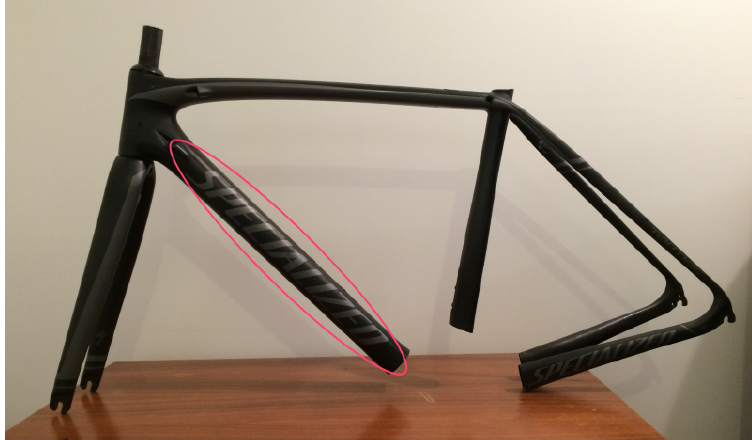
Figure 1. Inspected bicycle